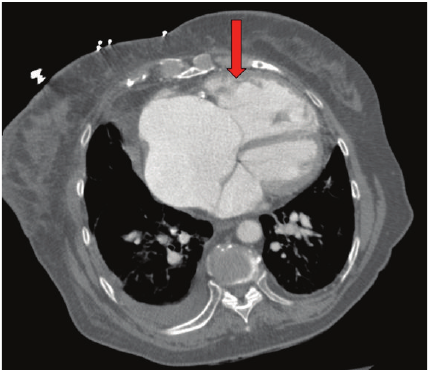
Figure 1: CT-scan showing right ventricular enlargement (red arrow).